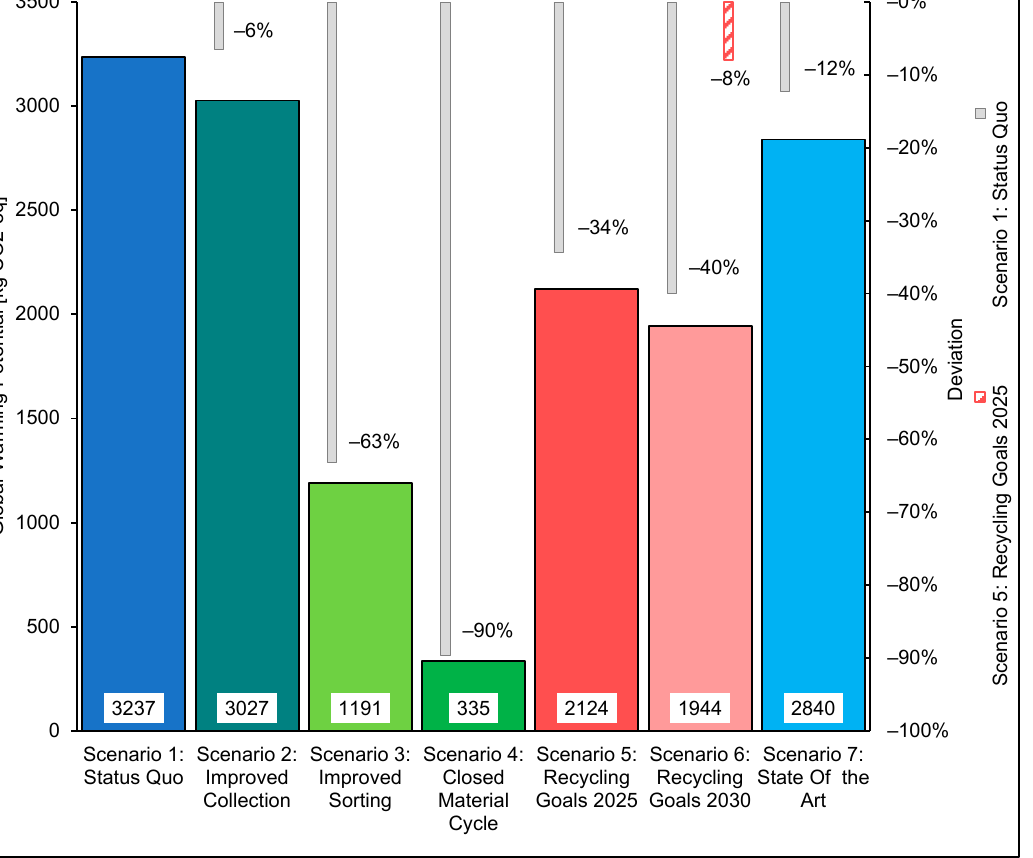
Figure 15. Global warming potential (GWP)–scenario overview.